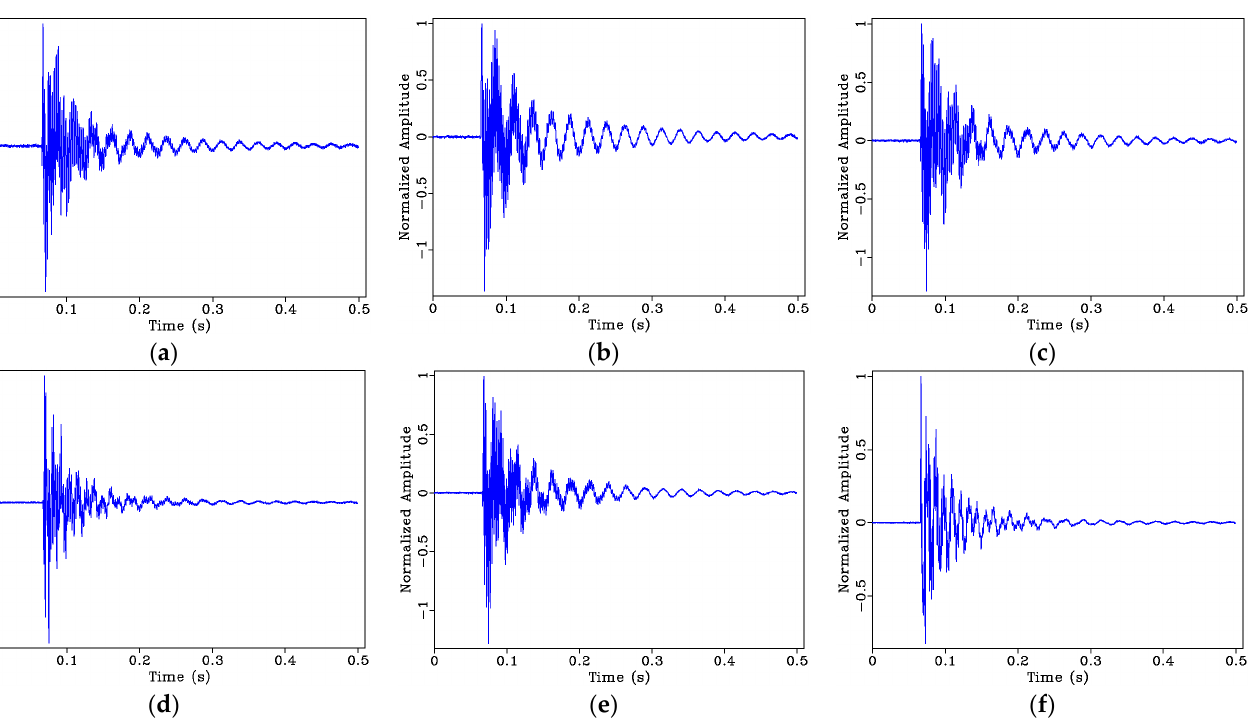
Figure 13. Normalized post-damage acceleration response signal: ( a ) cr8-2; ( b ) cr8-8; ( c ) cr8-14; ( d ) cr14-2; ( e ) cr14-8; ( f ) cr14-14.